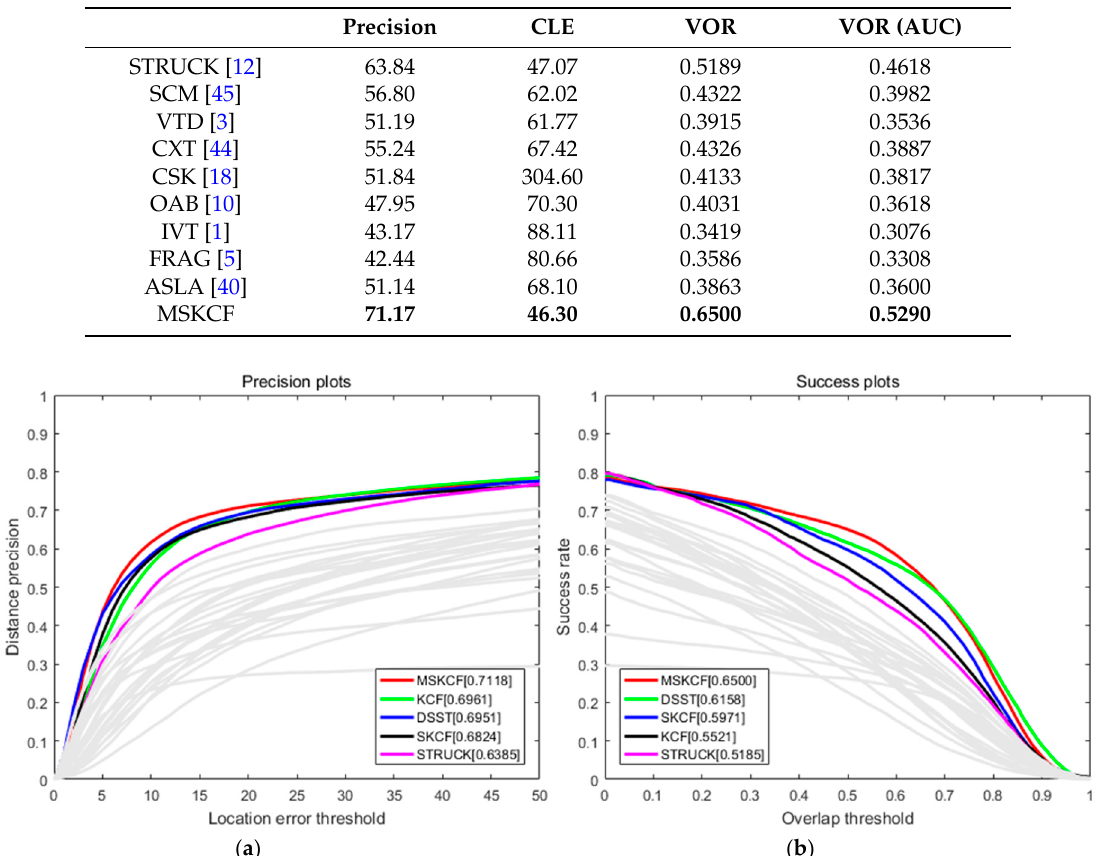
Figure 6. Precision ( a ) and success ( b ) plots over all 100 sequences using OPE for 29 trackers in [38]. The results of the top five ranks are indicated via the legend in the figure, and the other trackers are indicated using gray colored lines.